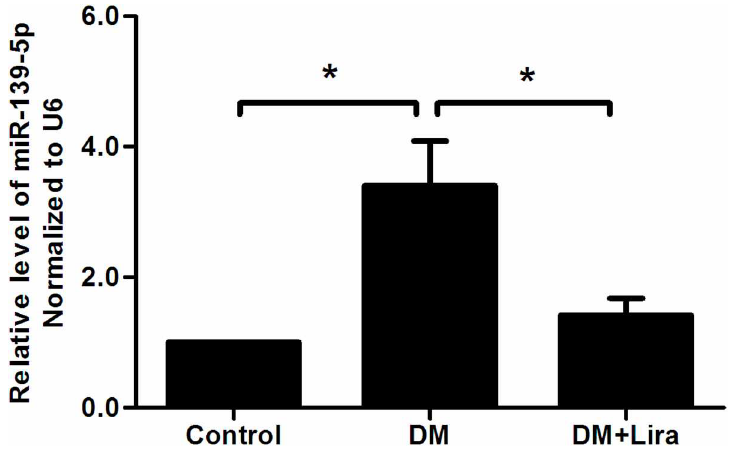
Fig 5. MiR-139-5p expression after liraglutide treatment by qRT-PCR ( * p < 0.05). (Controlgroup, DM group, and DM + liraglutidegroup: 1.0, 3.4 ± 0.68, 1.4 ± 0.3, p < 0.05).Diabeticrats were dividedinto two groups, administered without (DM group) or with liraglutide(DM + Lira group) at a dose of 200 μ g/kg/d. SD rats of control group were fed with normalchew and received subcutaneous injectionof saline.